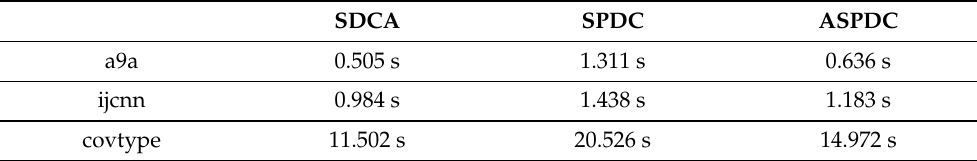
Table 3. The running time for dual-gap approaches to the given precision (10 − 6 ) when λ =